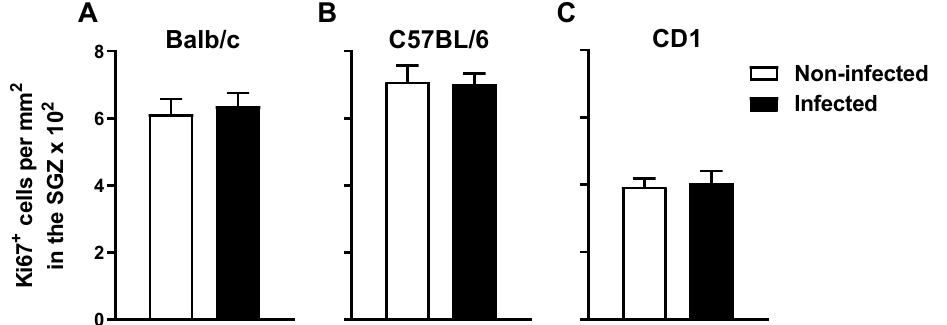
Figure 3. Chronic infection with M. avium does not alter the hippocampal cell proliferation. Hippocampal cell proliferation was assessed in M. avium infected and non-infected Balb/c ( A ) C57BL/6 ( B ) and CD1 ( C ) mice. The bars represent the mean + SEM of Ki67 + cells per mm 2 in the SGZ of each animal (6–8 mice per strain from 2 independent